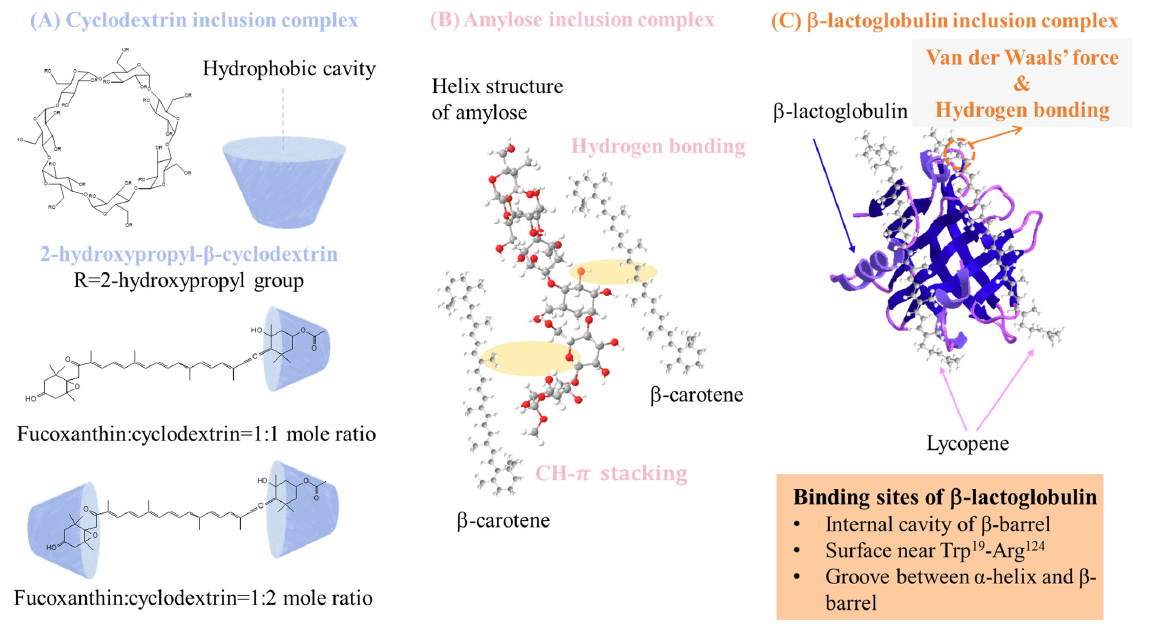
Figure 9. Scheme diagrams of ( A ) cyclodextrin, ( B ) amylose, and ( C ) β -lactoglobulin inclusion complexes [81–83] .